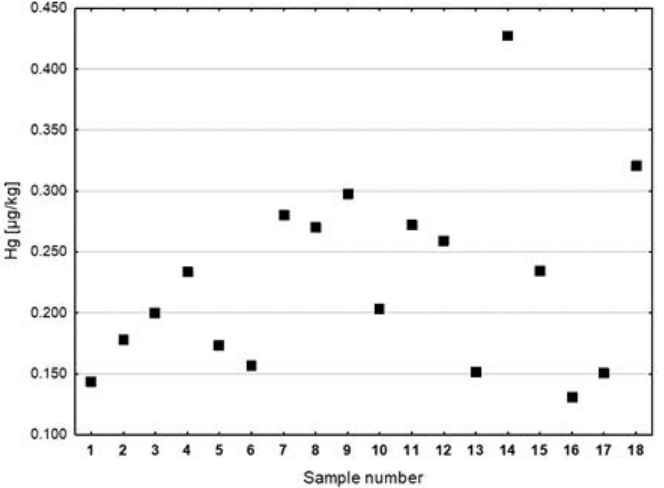
Figure 5. Hg concentrations in dietary supplements made with vegetable oil (µg/kg). Based on the analysis of the test results, none of the tested dietary supplements ex- ceeded the permissible level of mercury (0.10 mg/kg) [38].